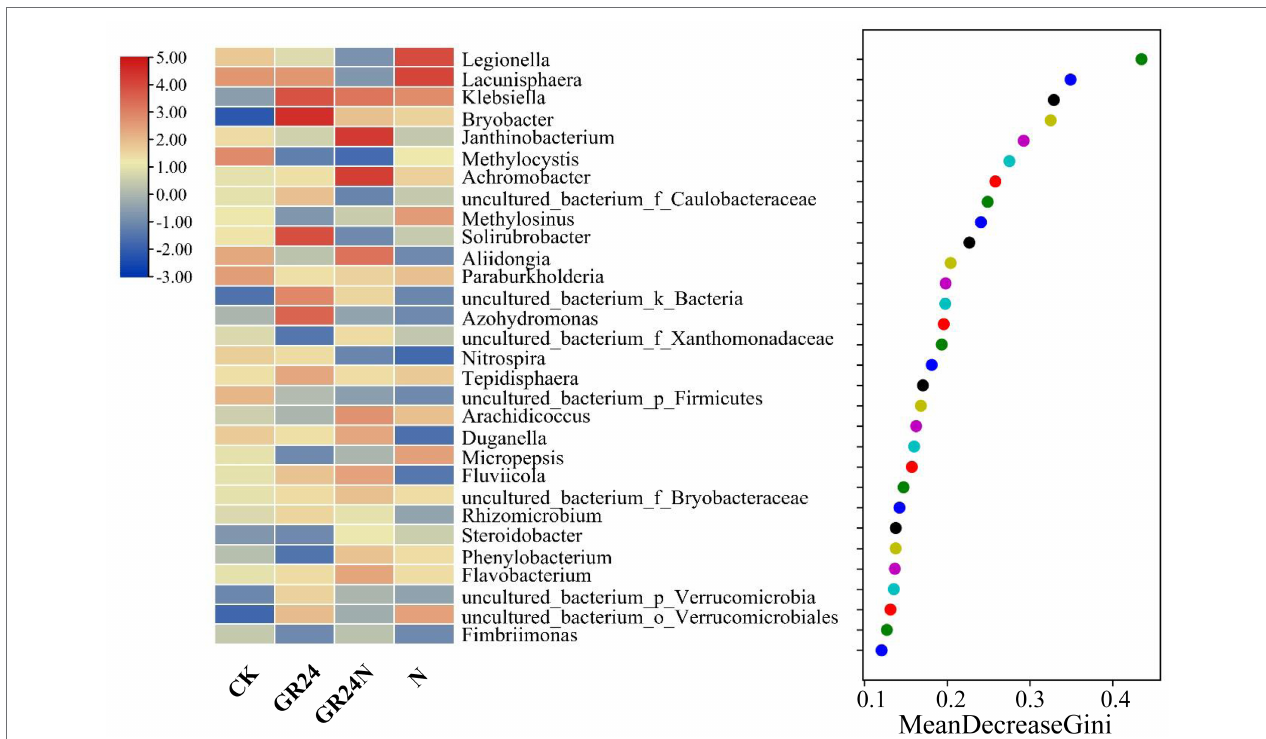
FIGURE 7 | Random forest classification analysis of dominant bacteria in additional N deposition and GR24